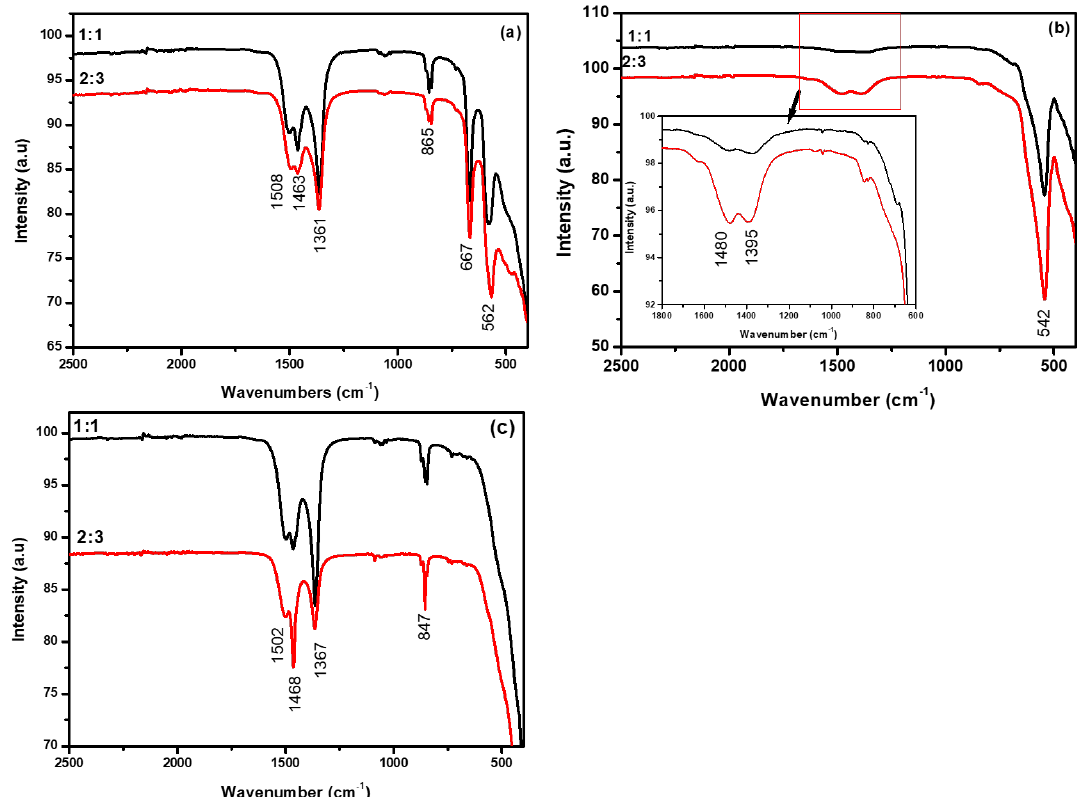
Figure 3. FT-IR spectra of the La composites for ( a ) LaCoO 3 , ( b ) LaFeO 3 , and ( c ) LaNiO 3 with ratios of 1:1 and 2:3. of 1:1 and